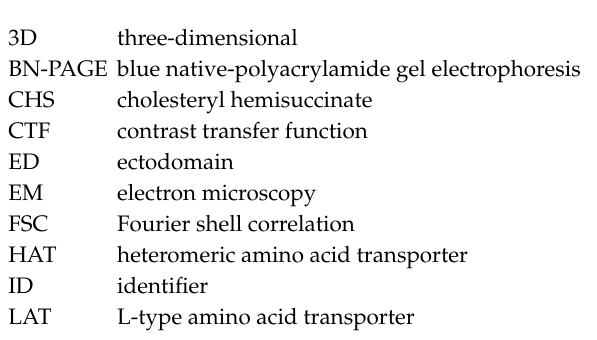
Supplementary Materials: Supplementary Table 1 (Table S1) can be found at http://www.mdpi.com/1422-0067/